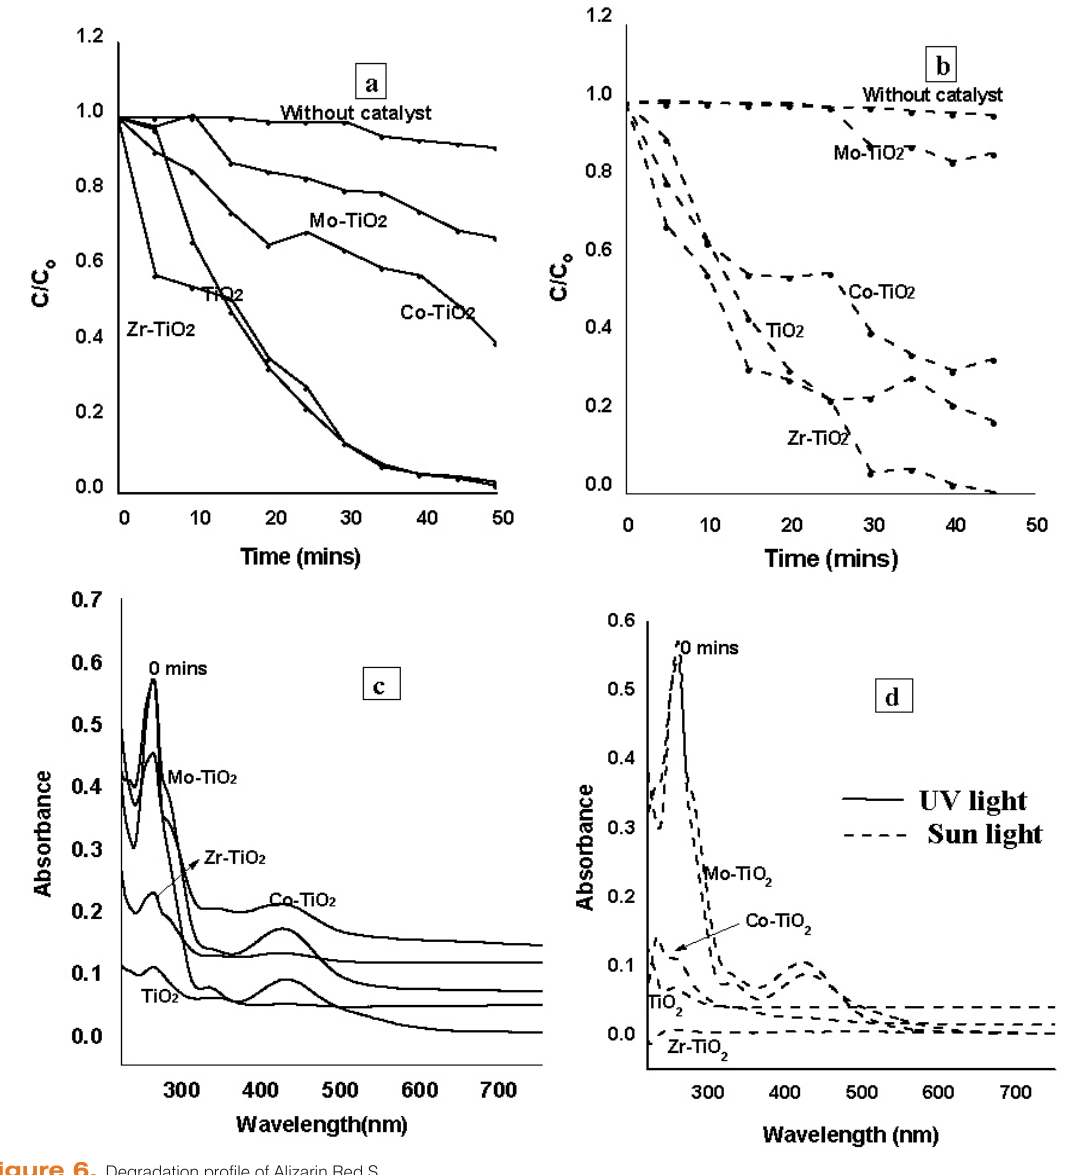
Figure 6. Degradation profile of Alizarin Red S. a. Exponential decay of Alizarin Red S during photodegradation (UV). b. Exponential decay of Alizarin Red S during photodegradation (sunlight). c. UV-Visible spectra of degradation (UV) of Alizarin Red S with different catalysts after 25 minutes. d. UV-Visible spectra of degradation of Alizarin Red S with different catalysts after 45 minutes